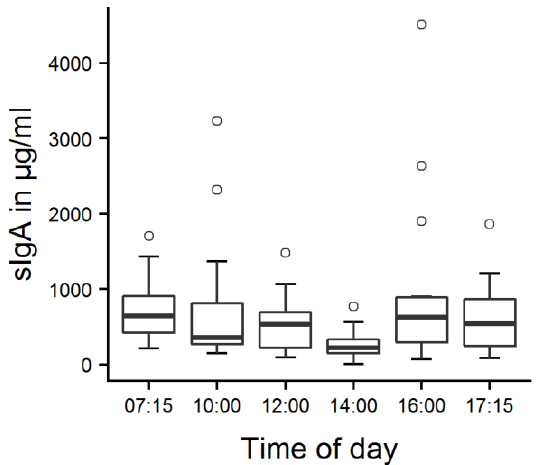
Figure 3. Calves’ salivary sIgA concentrations at di ff erent points in time. Fourteen calves were tested on two consecutive days; values were averaged per calf and point in time. There was a main e ff ect of time (LMM, p < 0.001); the values at 14:00 were significantly lower than the values at all other points in time according to Tukey contrasts ( p = 0.001 – 0.022).